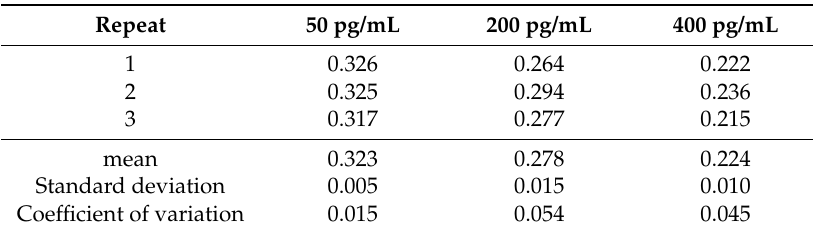
Table 2. Three repeats of each of three sample concentrations were measured using the prototype assay system to demonstrate the combined variability of the full assay